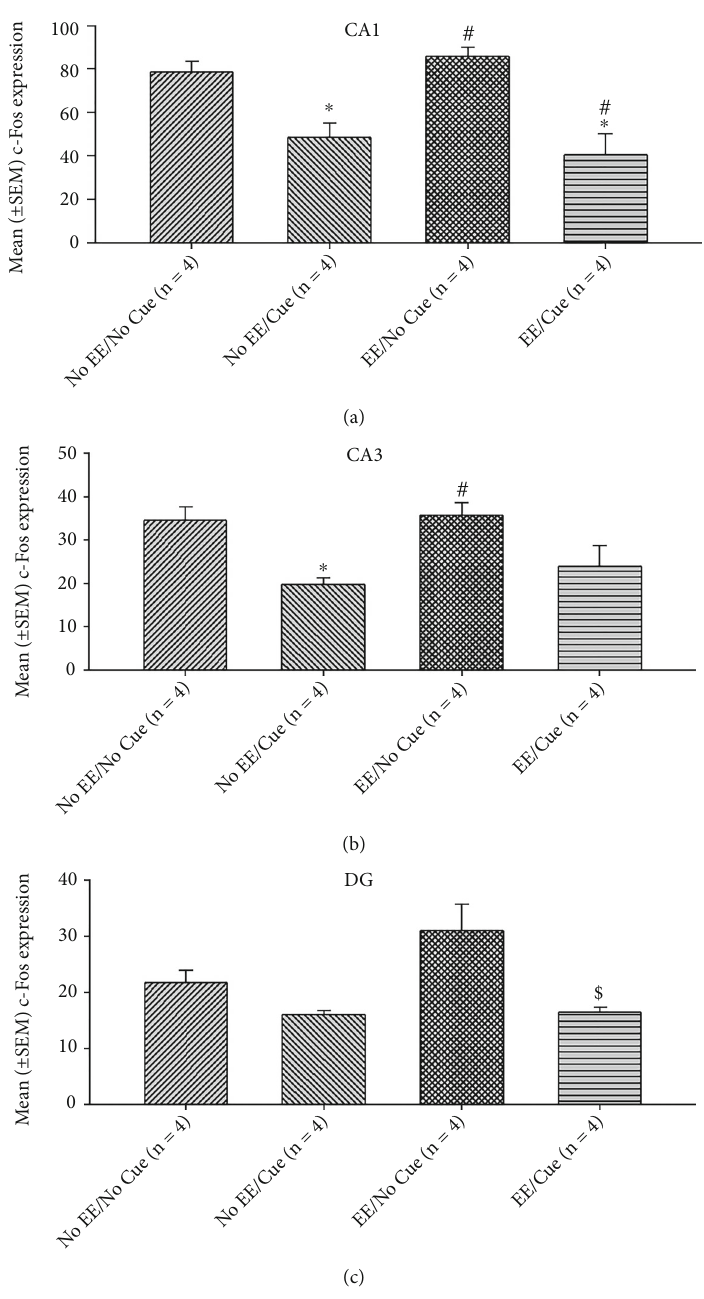
Figure 11: Mean ( ± SEM) c-Fos expression in the CA1 (a), CA3 (b), and DG (B) for the no EE/no cue ( n = 6 ), no EE/cue ( n = 6 ), EE/no cue ( n = 6 ), and EE/cue groups ( n = 6 ). EE: environmental enrichment. ∗ p < 0 : 05 indicates signi fi cant di ff erences compared to the no EE/no cue group; # p < 0 : 05 indicates signi fi cant di ff erences compared to the no EE/cue